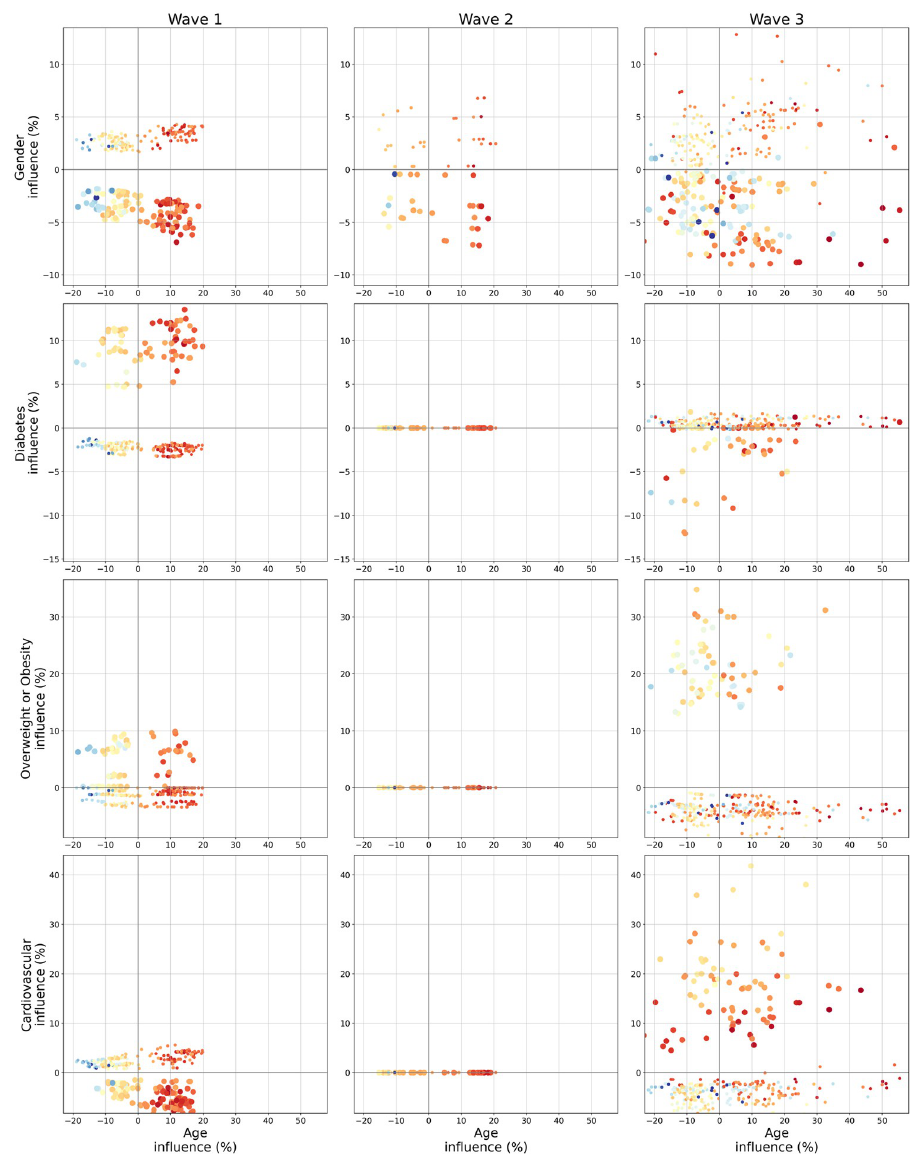
Fig 5. Bivariate graph for Age and its interaction with Gender, Diabetes, Overweight or Obesity and Cardiovascular for each wave (best viewed in color). For each row, Age influence is on the x-axis while Gender, Diabetes, Overweight or Obesity and Cardiovascular are on the y-axis respectively for the first, second, third and fourth row. Each dot represents a particular patient. Color and size of the dot give information about the two feature initial values, respectively color for the feature located on the x-axis (here age) and size for the feature on the y-axis. The colormap for the x-axis feature is the same used in Fig 3 with blue indicating a young age and red an old age. Since the y-axis features are all binary indicators, a small point indicates a 0 (men or absence of comorbidity) and a bigger dot a 1 (women or comorbidity presence).